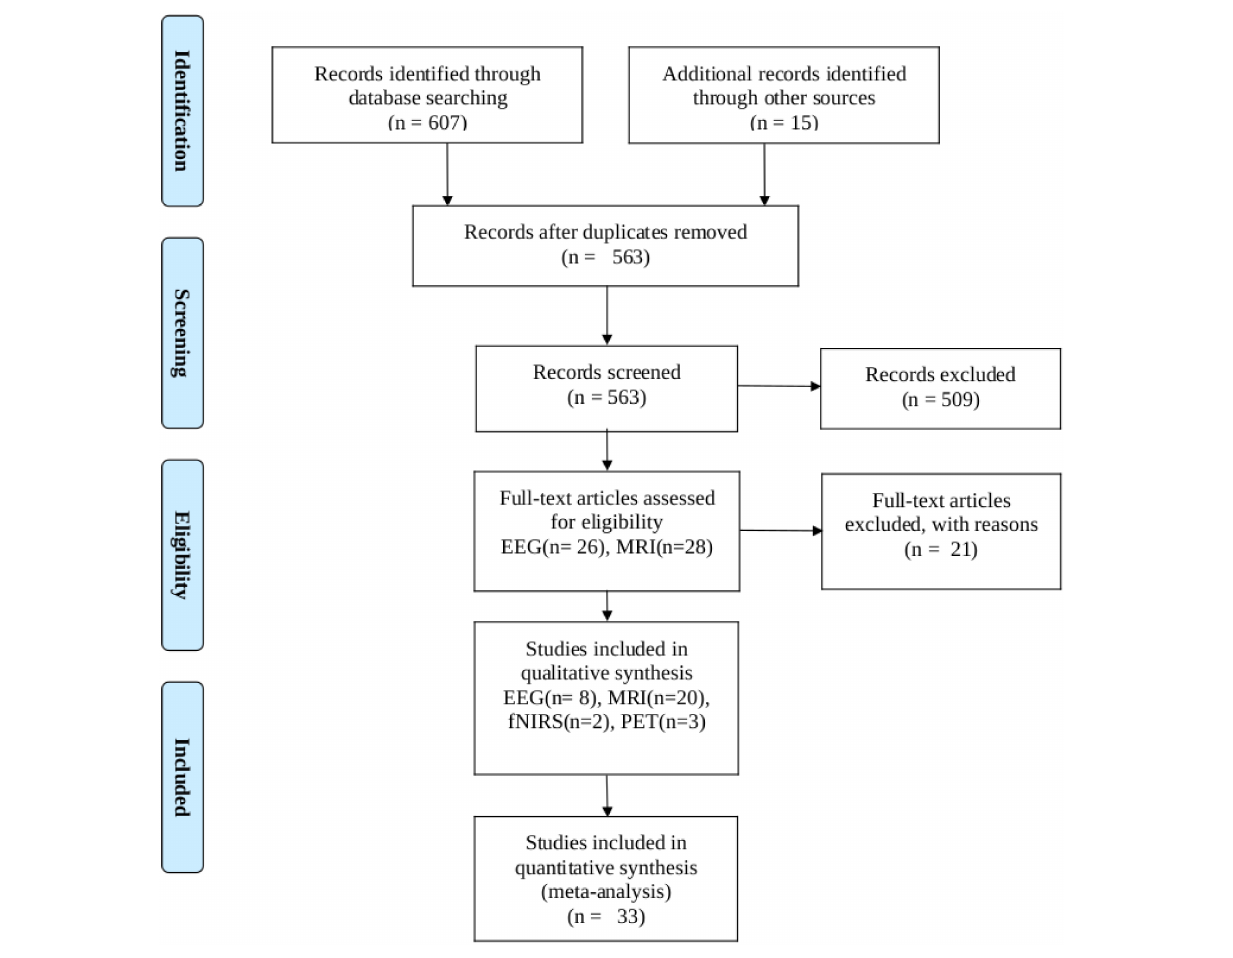
FIGURE1 PRISMA flow diagram depicting the study selection process. The search was performed in PubMed up to 12 March